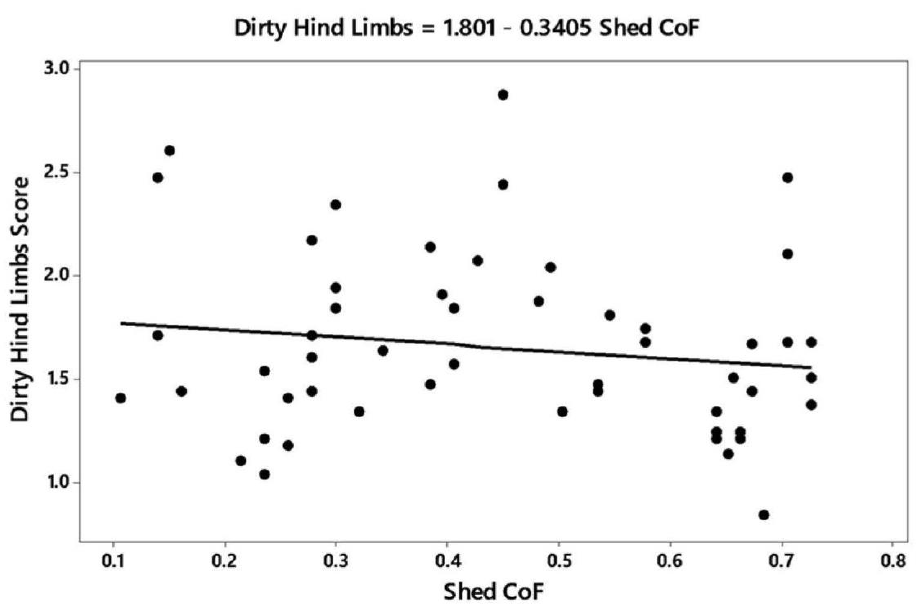
Figure 3. Scatter plot showing relationship between dirty hind limbs score and coefficient of friction (CoF) of shed floor.